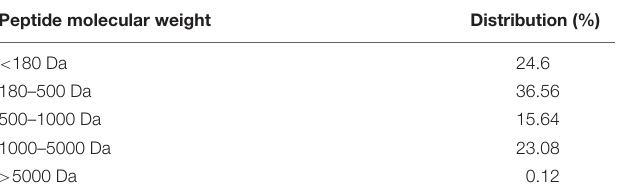
TABLE 2 | Distribution of molecular weight of peptides of protein hydrolysate. Peptide molecular weight